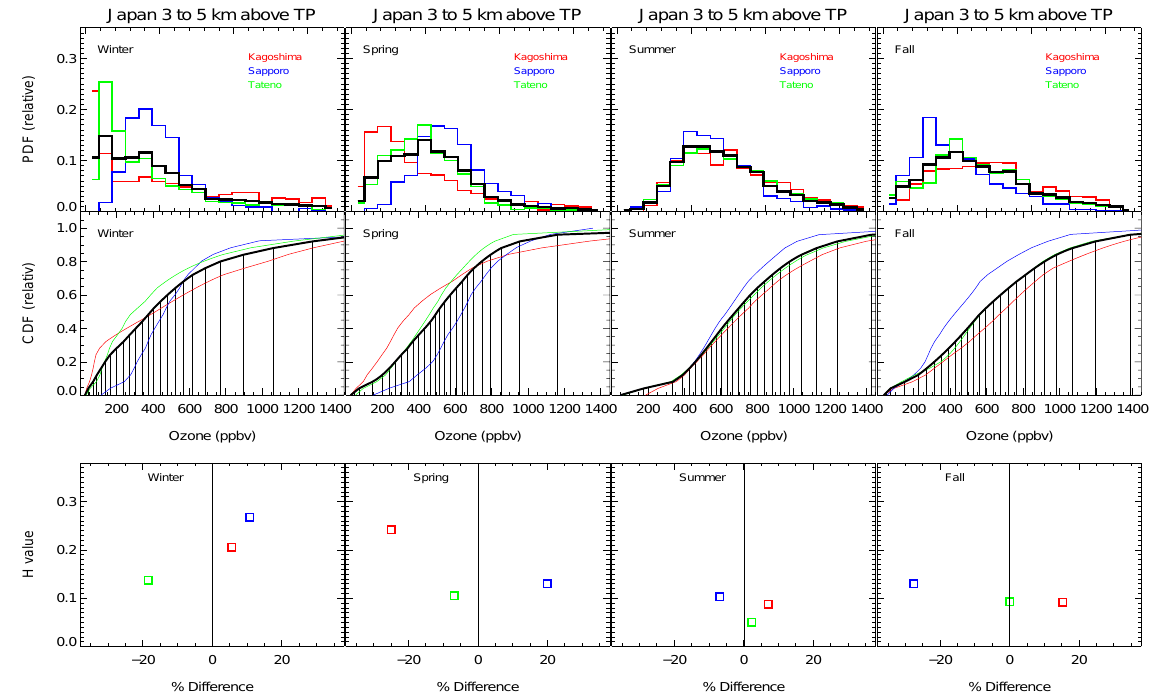
Fig. A1. Probability distribution function (PDF) of ozone for the three stations within Japan (different colors) for four seasons. The regionally-aggregated distribution is shown as black thick lines. Middle row: cumulative Distribution Functions (CDF) of ozone for the three stations (thin lines) and for the regionally aggregated distribution (average distribution of ozone from all three stations (thick black line)) using variable bin sizes for the underlying PDF. Bottom panel: Hellinger distance between different stations (different colors) and the regionally aggregated distribution plotted against the median differences of the two distributions. Distribution samples are from data within 3–5km above the